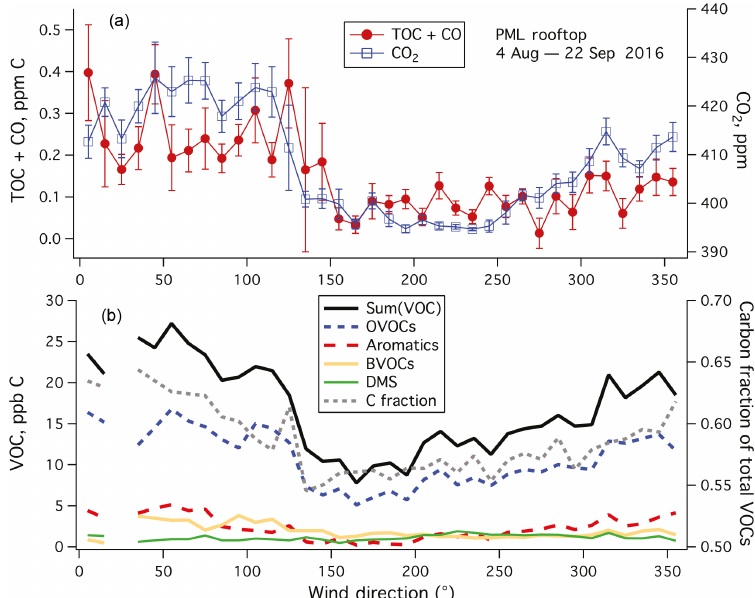
Figure 6. (a) TOC + CO and CO 2 and (b) Sum(VOC) and speciated VOC averaged to 10 ◦ wind direction bins. Error bars indicate standard errors. TOC + CO, CO 2 , and Sum(VOC) showed higher values when winds were from land (north to southeast) than when winds were from the ocean (southwest). Most VOCs had a lower mixing ratio in marine air than in air from land except for DMS. Amongst speciated VOCs measured by the PTR-MS, OVOCs dominated in terms of carbon mass. The fraction of carbon in the total speciated VOC mass was also lower in marine